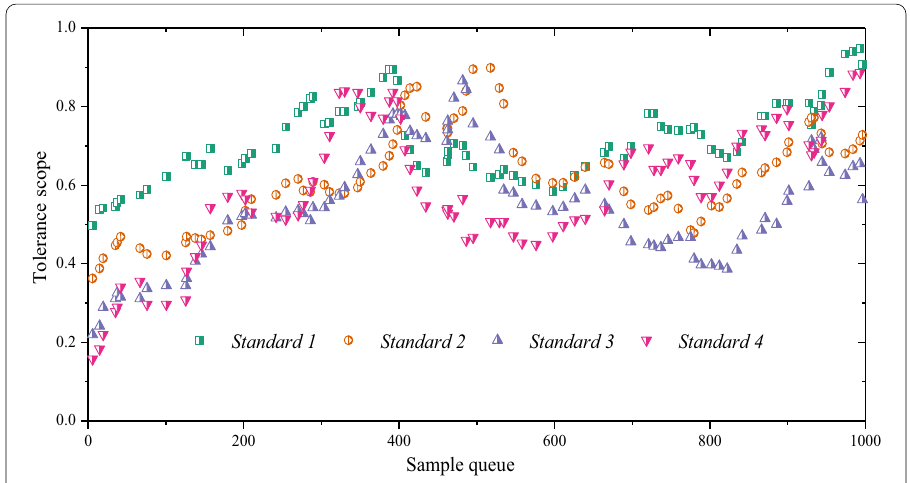
Fig. 8 Comparison results of running training efficiency based on wireless